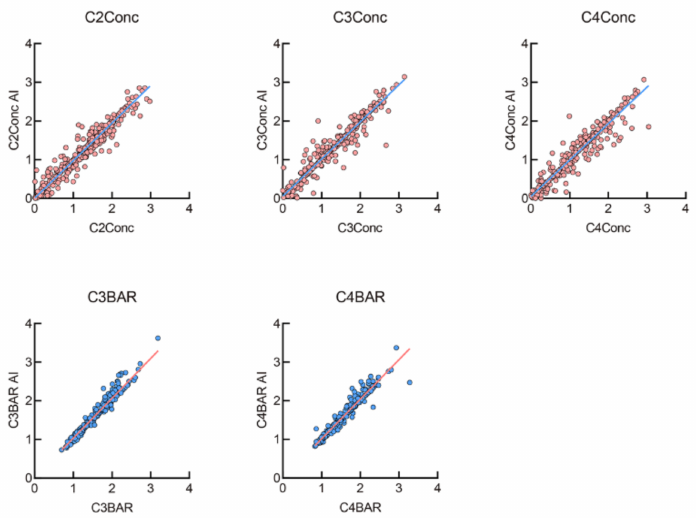
Figure 6. The linear and ratio measurements difference between AI and human. They were well- matched and fitted into Y = X, R 2 = 0.93, 0.94, 0.93, 0.97 and 0.95, respectively; all p < 0.001).